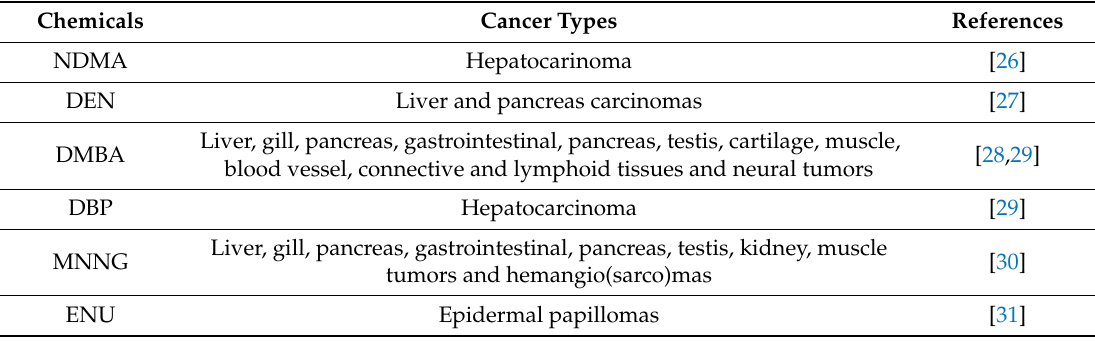
Table 1. Zebrafish cancers induced by chemical